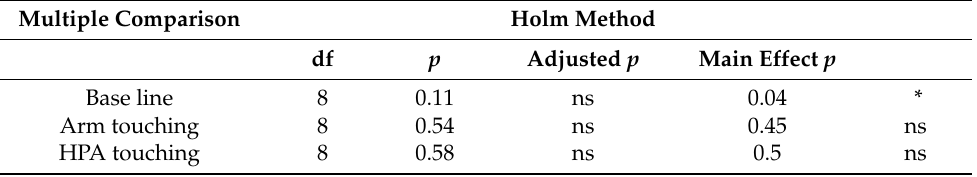
Table 4. The result of multiple comparison of S value in the trauma group. Multiple